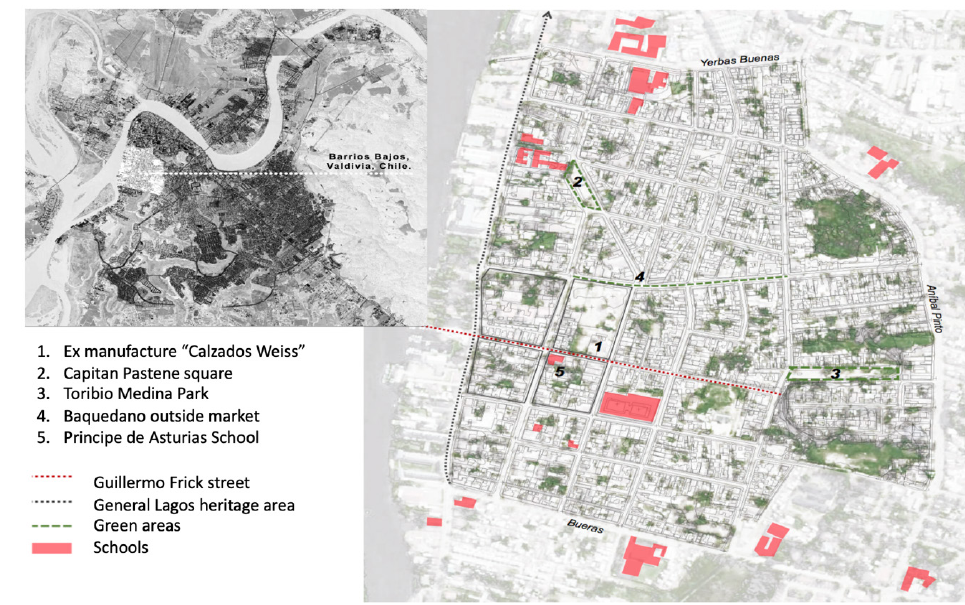
Figure 1. Location of Barrios Bajos sector within the city of Valdivia (left). Location of the case studies in the urban area under study (right)